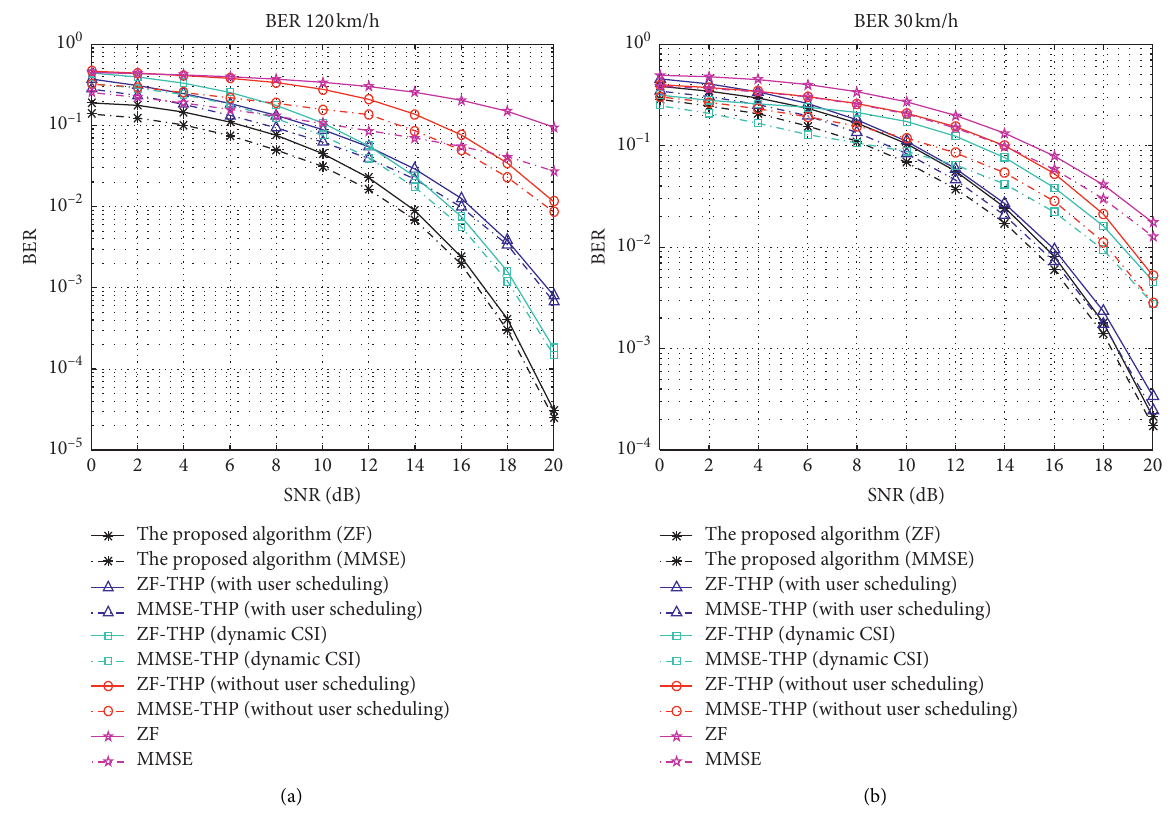
Figure 4: BER of several precoding algorithms: (a) 120km/h; (b)